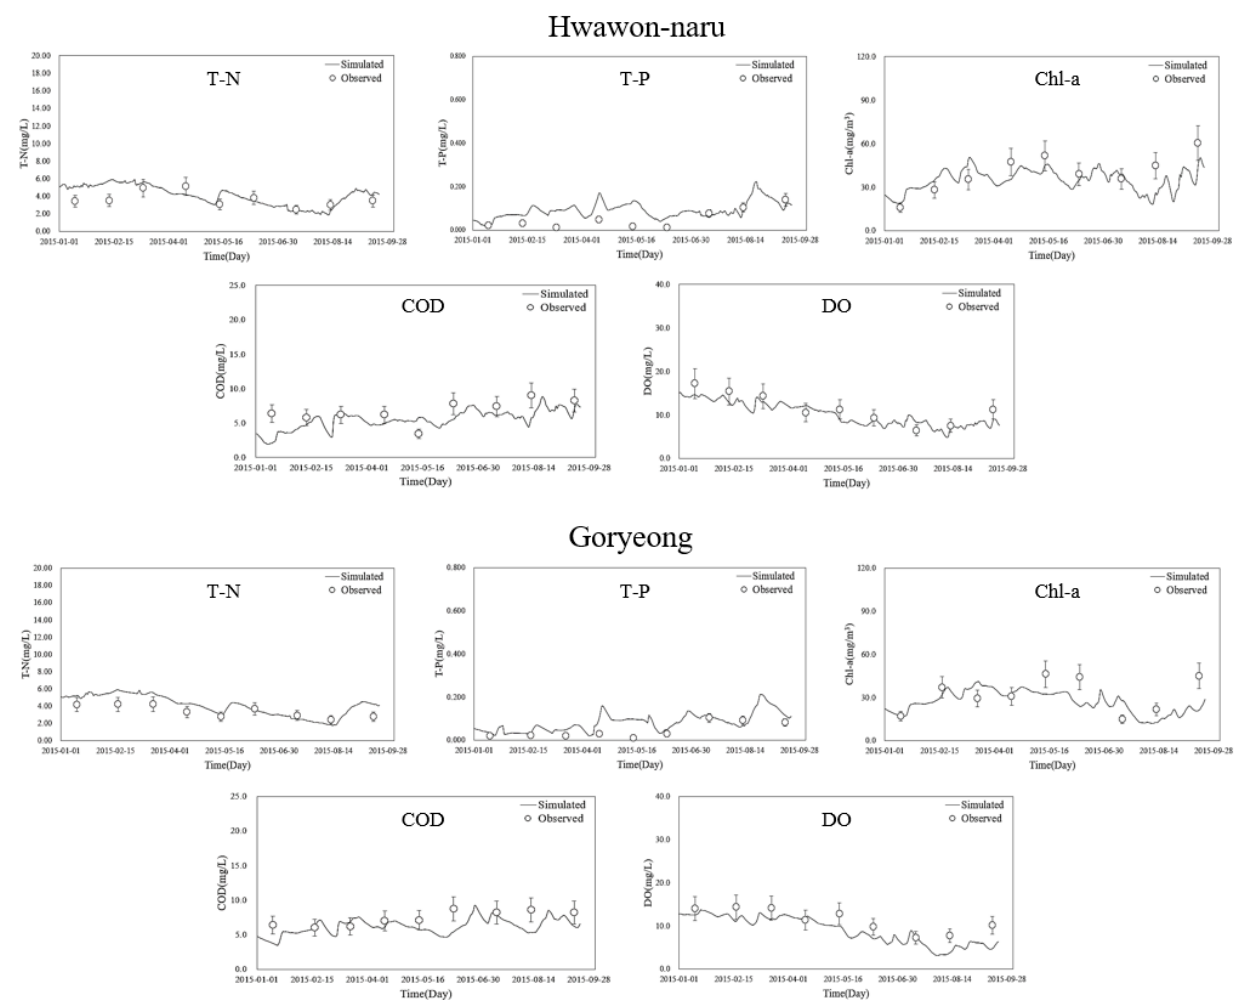
Figure 6. Water Quality Simulation Validation (From January 2015 to December 2015) .